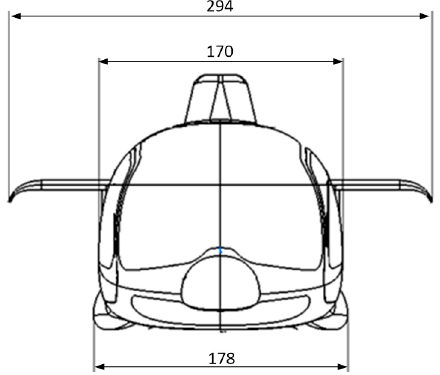
Figure 3. Geometric dimensions (mm) of the test object (front view).